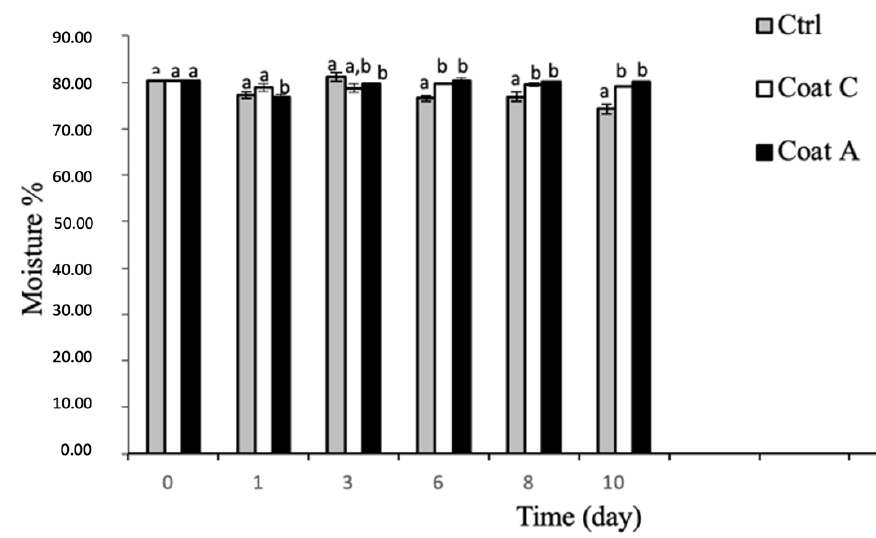
Figure 2. Moisture content (percentage) in the control and coated prickly pears stored at 4 °C. a,b Different superscript letters indicate that means are significantly different ( p < 0.05). Ctrl = sample without coating; Coat C = sample with alginate coating; Coat A = sample with alginate and peels. Microbial proliferation in coated and uncoated samples was quite different (Figure